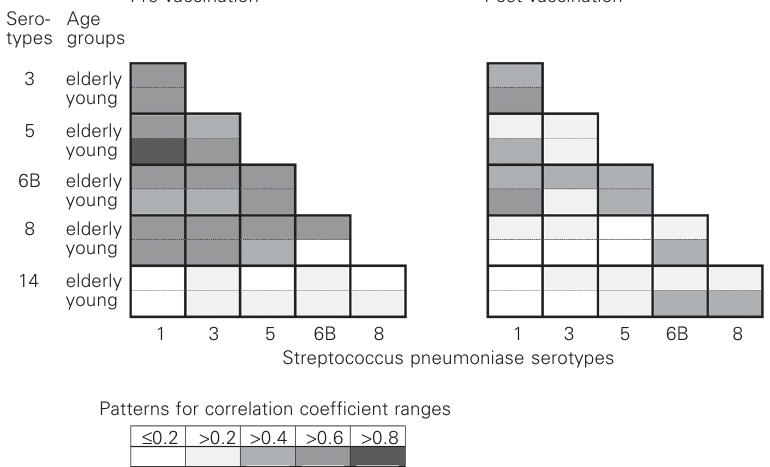
Figure 3. Correlation coefficients for antibody concentration between pairs of pneumococ- cal capsular polysaccharides in pre- and post-vaccination sera from 102 elderly subjects and 19 young adults. Degrees of correlations are indicated by shading